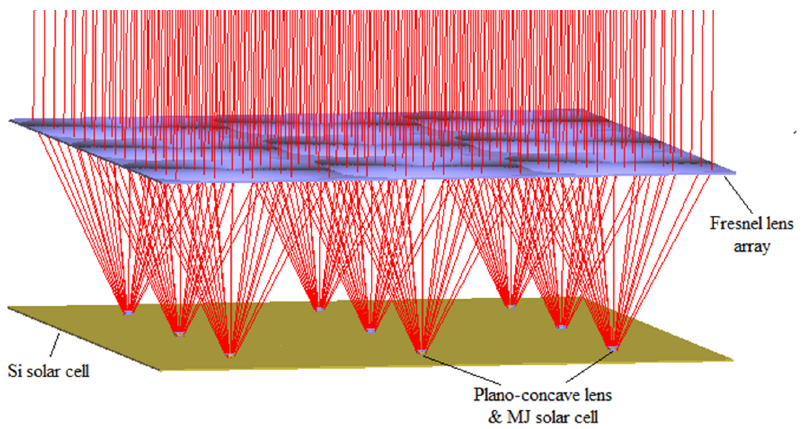
Figure 2. Array layout of the CPV system. MJ, multi ‐ junction.